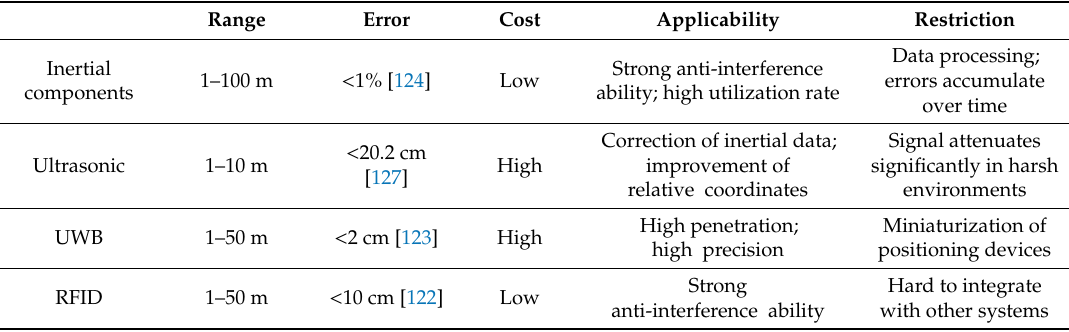
Table 5. Short-range positioning techniques that satisfy local battlefield positioning conditions. Range Error Cost Applicability